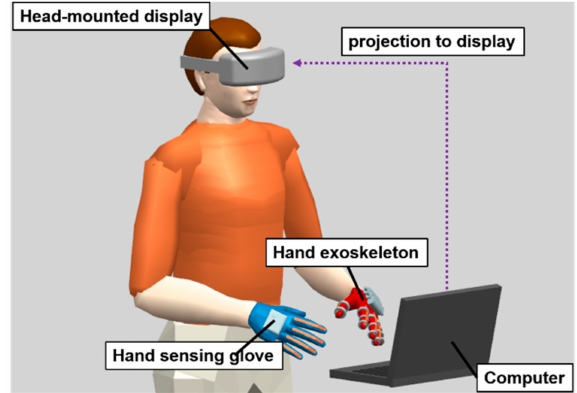
Figure 7. Framework of the virtual reality game including hand exoskeleton, hand-sensing glove, computer, and head-mounted display (optional).